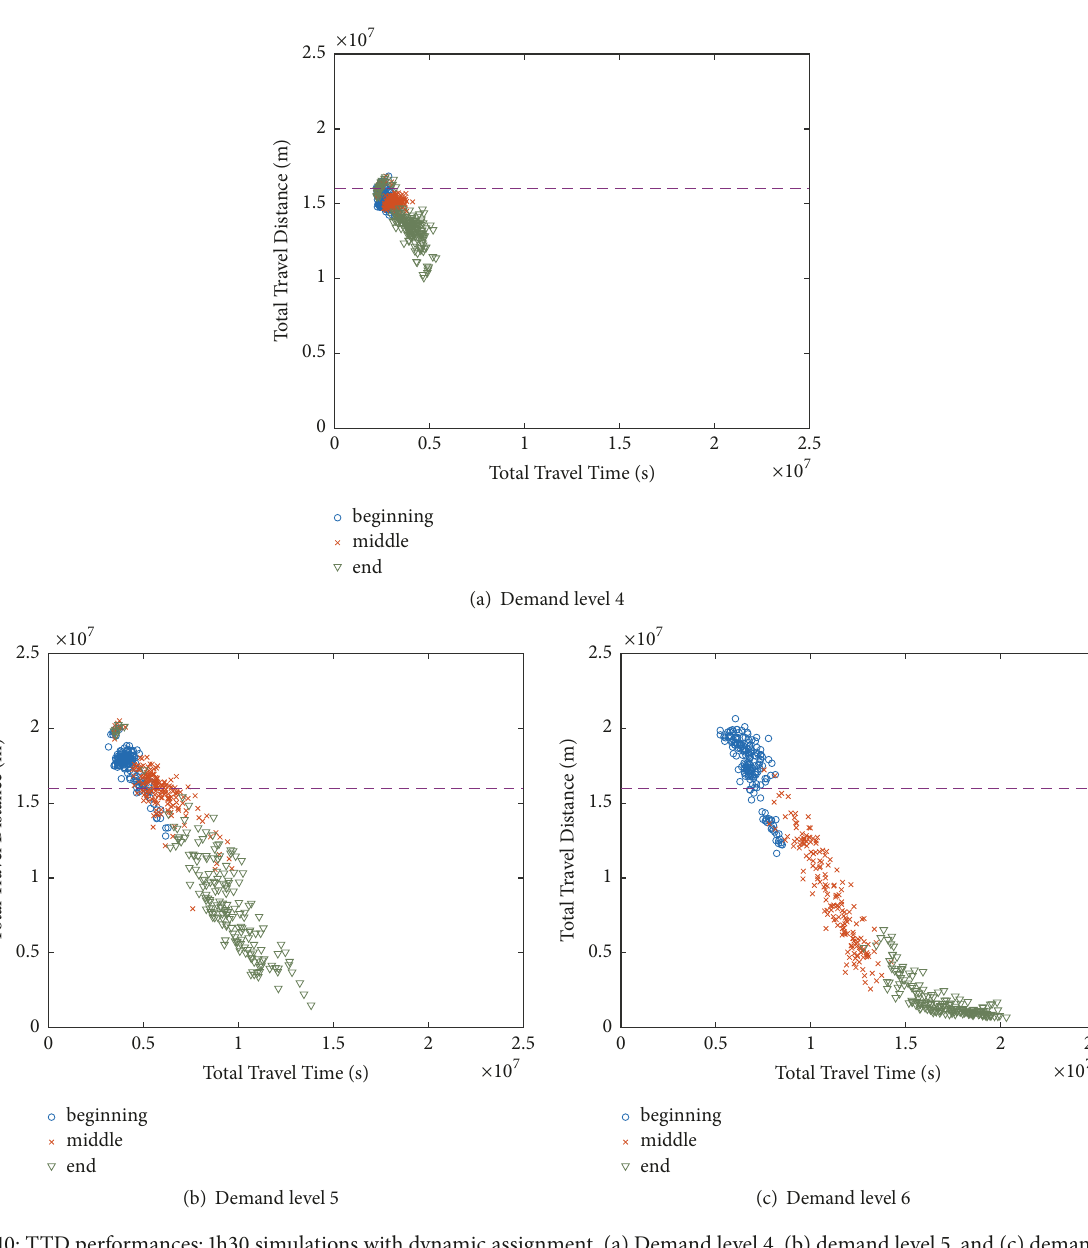
Figure 10: TTD performances: 1h30 simulations with dynamic assignment. (a) Demand level 4, (b) demand level 5, and (c) demand level 6.